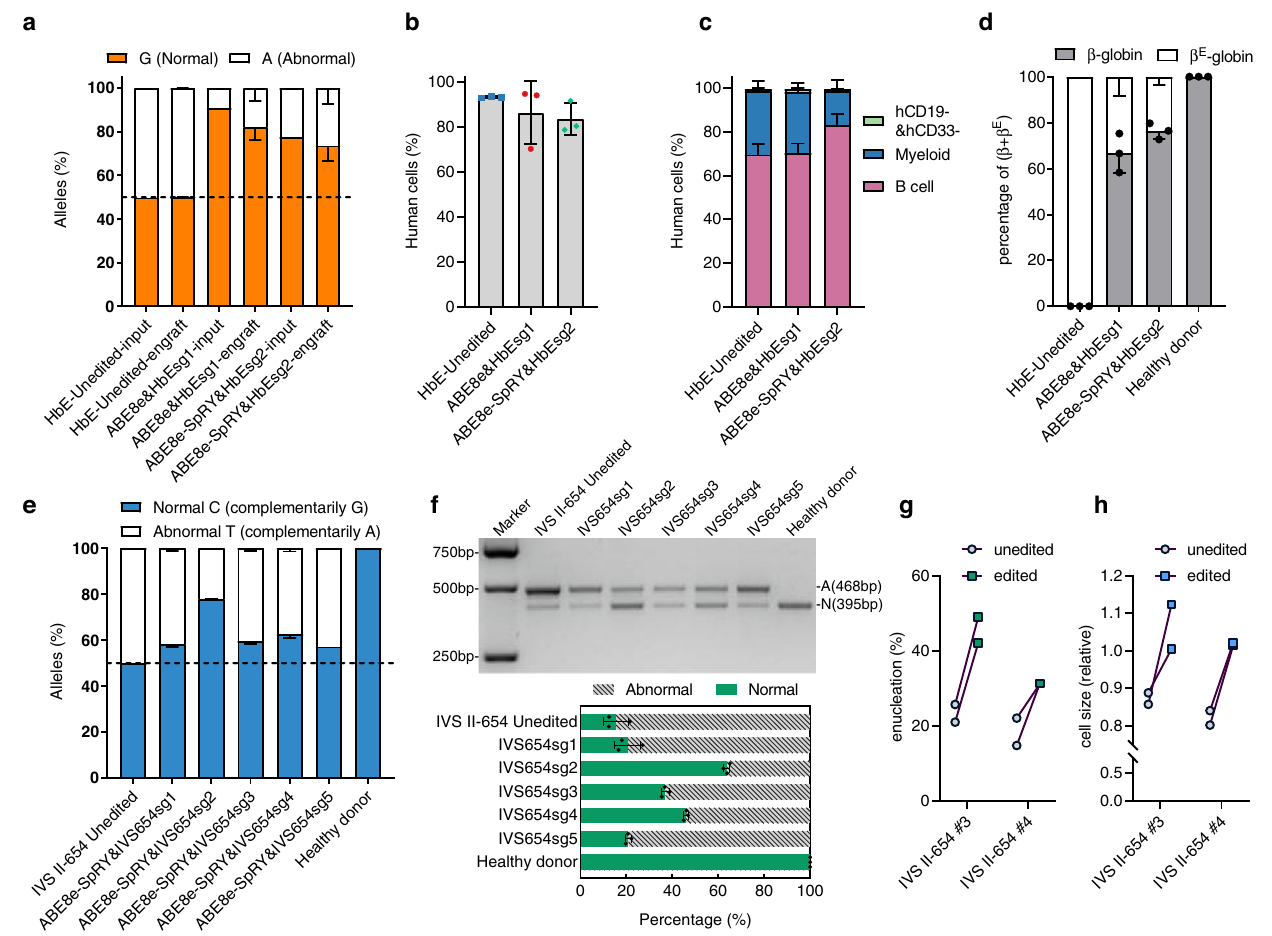
Fig. 4 | ABE8e-SpRY therapeutic base editing in β hemoglobinopathy patients ’ CD34+ HSPCs. a Targetsite allele frequencyafterABE8e or ABE8e-SpRY editing in HbE/ β -thalassemia patient ’ s CD34 + HSPCs (HbE #3) and engrafts. Data are plotted as mean±sd, n =3 mice for each edited group. b The bone marrow chimeras were analyzed16weeksaftertransplantation,measuredfromgraftsofHSPCsfromHbE/ β -thalassemia patient donors (HbE #3) edited by ABE8e targeted to HbEsg1 and ABE8e-SpRY targeted to HbEsg2 sites, respectively. Data are plotted as mean±sd, n =3 mice for mock and each edited group. c Percentage of engrafted human B cells,myeloidcells,andCD19 − CD33 − cells,measuredfromgraftsofHSPCseditedby ABE8e targeted to HbEsg1 and ABE8e-SpRY targeted to HbEsg2 sites, respectively. Data are plotted as mean±sd, n =3 mice for mock and each edited group. d RP- HPLC analysis of hemoglobin expression in mouse bone marrow CD235a + cells transplanted with ABE8e or ABE8e-SpRY edited HbE/ β -thalassemia patient cells(HbE#3).Dataareplottedasmean±sd, n =3mice. e Allelefrequencyoftarget